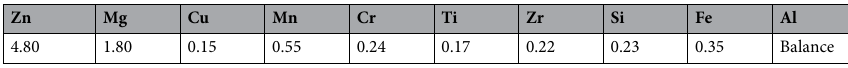
Table 1. Chemical compositions of the tested material (wt.%).